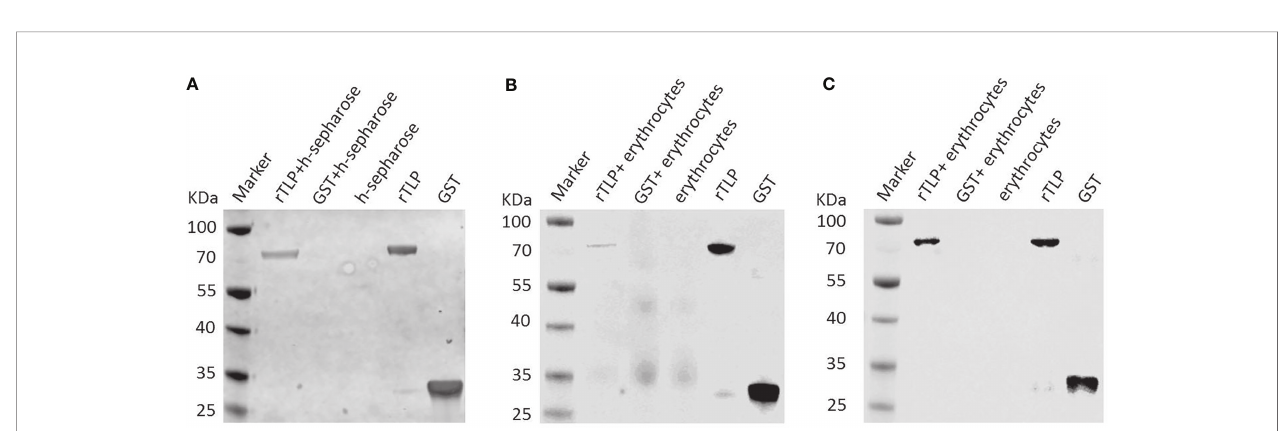
FIGURE 4 | Binding activity of recombinant Bm Trx-like protein ( Bm TLP). The glutathione S-transferase (GST) tagged r Bm TLP (rTLP) and GST protein (GST) were incubated with (A) heparin-sepharose (h-sepharose), (B) mouse erythrocytes, or (C) human erythrocytes at 25°C for 2 h Recombinant proteins was incubated with sepharose without heparin as negative control. Eluted proteins were collected and detected by western blot. The GST tagged r Bm TLP and GST were used as positive controls. Rabbit anti-GST Tag monoclonal antibody was used as primary antibody. The results are representative of three independent